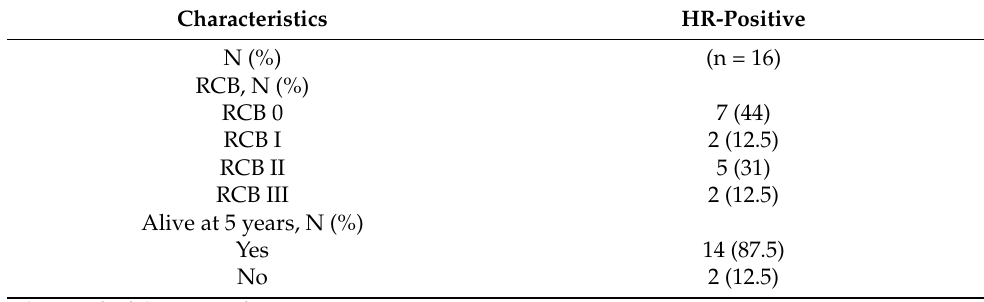
Table 3. Patient outcomes after neoadjuvant